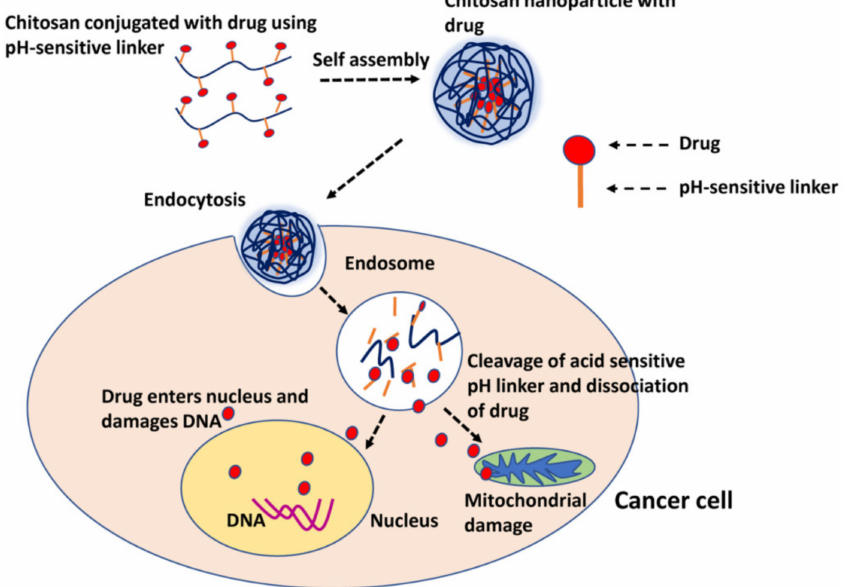
Figure 33. pH-responsive drug release of Tamoxifen from chitosan nanoparticles (adapted from